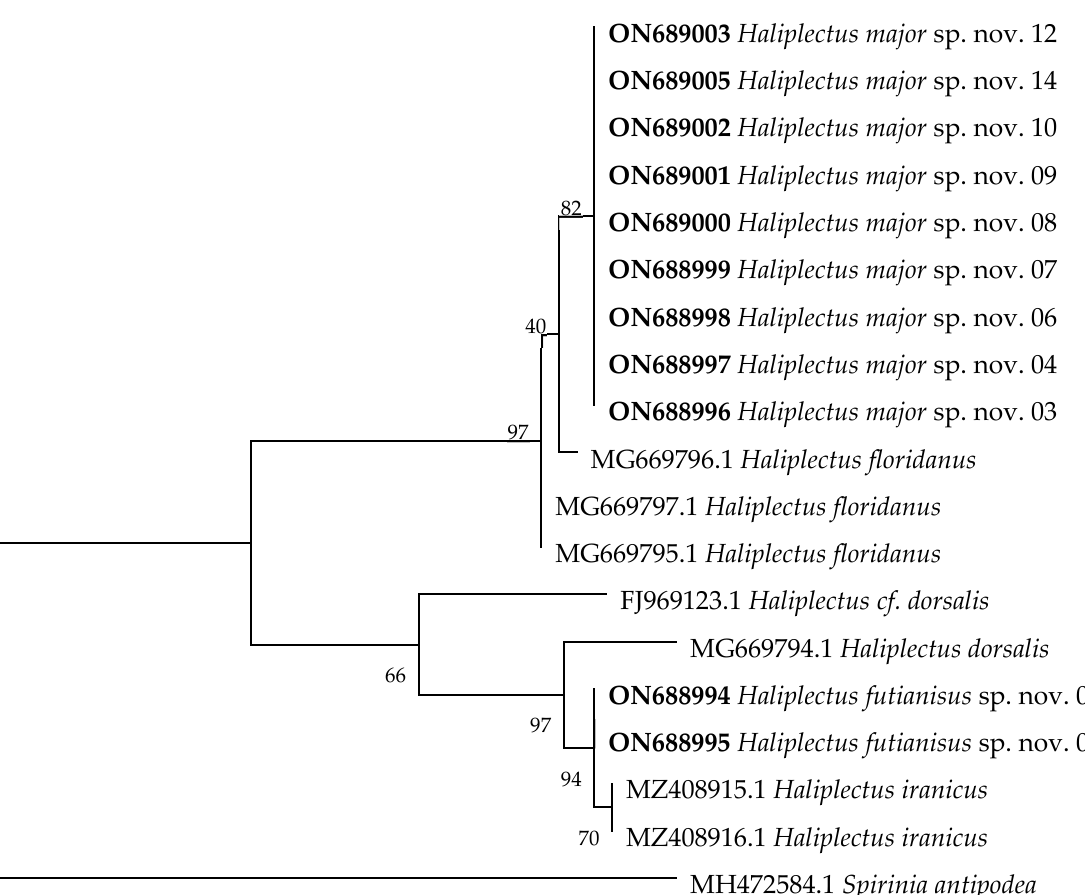
Figure 5. Maximum likelihood tree based on a 630 bp region of the 18S rRNA gene. The sequences highlighted in bold are from this study. Numbers above/below the branches indicate branch support based on 1000 bootstrap replicates.